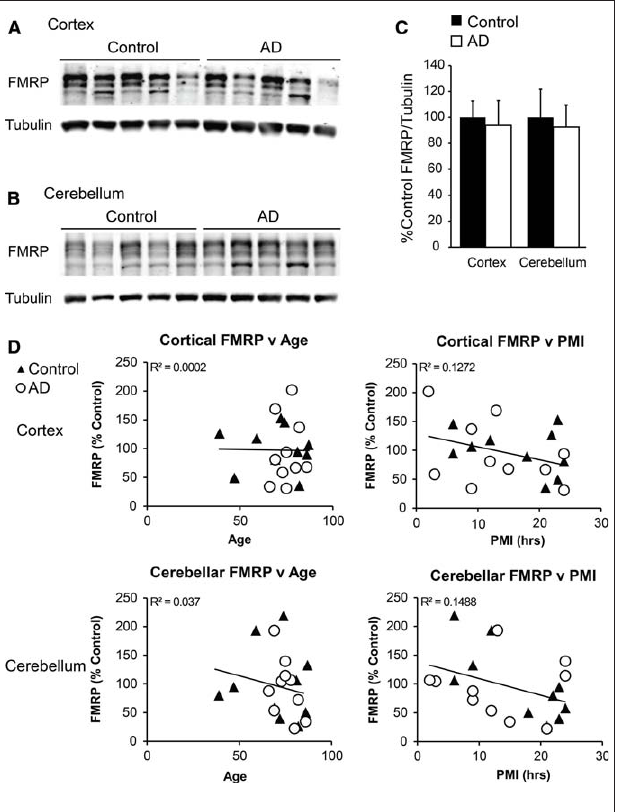
FIGURE 3 | FMRP expression in Alzheimer’s disease cortex and cerebellum. (A) Frontal cortex lysates from control ( n = 10) and autopsy-confirmed AD patients ( n = 10) probed with α -FMRP 17722. (B) Cerebellar lysates from the same patients as in (A) were evaluated concurrently. (C) Quantification of cortical and cerebellar FMRP/tubulin values performed in technical triplicate. (D) Normalized FMRP values were compared to individual patient ages and post-mortem indices. Diagnosis-independent best fit curves display overall trends in FMRP expression.